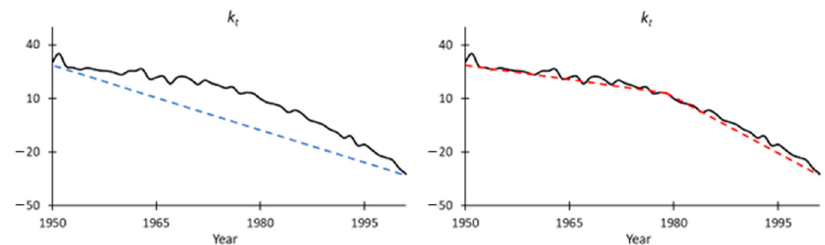
Figure 8. Parameter estimates of mortality index 𝑘 (cid:3047) under the original Lee-Carter model for the United Kingdom, calibrated on years 1950–2001. The red dashed line is based on two random walk processes connected at a breakpoint. The blue dashed line is based on a single random walk process over the whole fitting period.